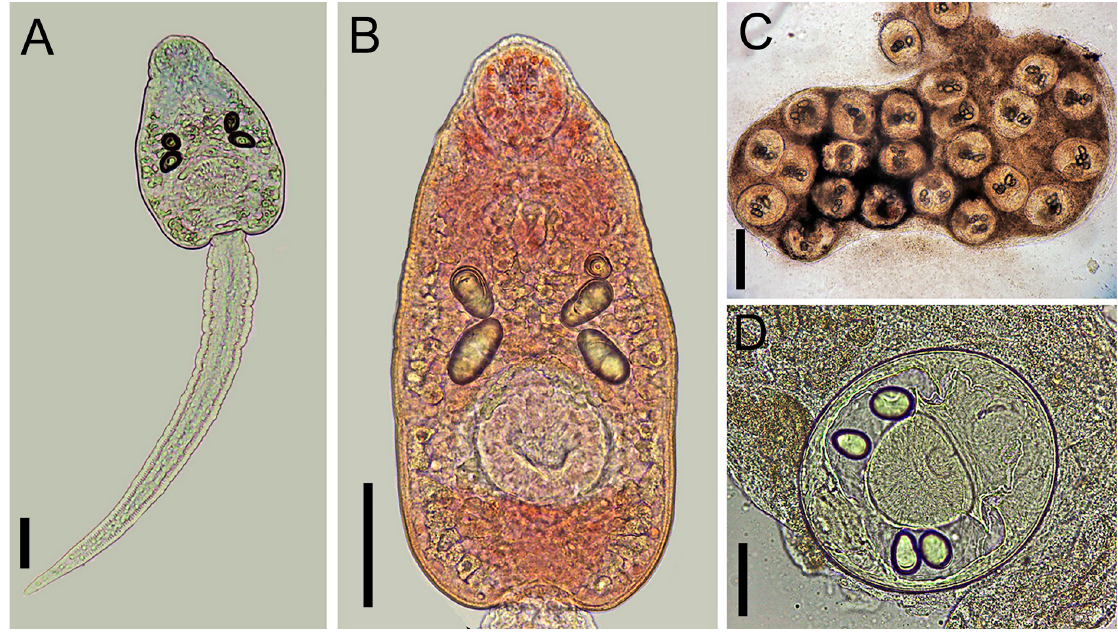
Fig 6. Larval stages of Rhopalias found in Biomphalaria glabrata and Rhinella sp. from Brazil. (A) Whole view of a cercaria stained with Nile blue sulphate. (B) Detail of the body of a cercaria stained with neutral red. (C) Metacercariae found in a naturally infected tadpole. (D) Detail of a metacercaria. Cercariae from the same infected snail were genetically identified as Rhopalias sp. 2. Scale bars: (A, B, D) 50 μ m, (C) 200 μ